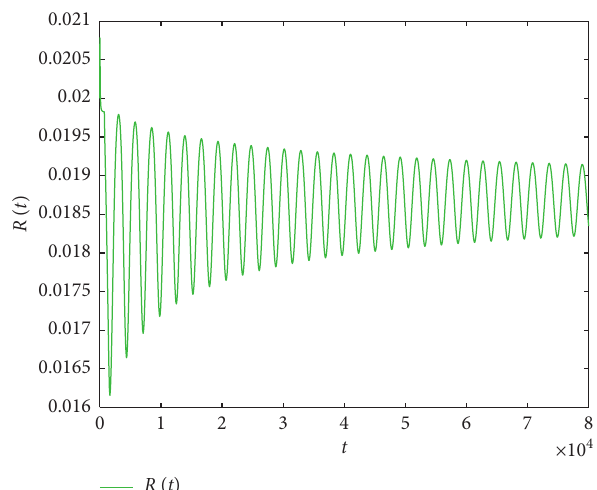
Figure 10: Time series solution of system (30) with ϕ � 0 . 90, � 728 . τ � 740 > τ 0